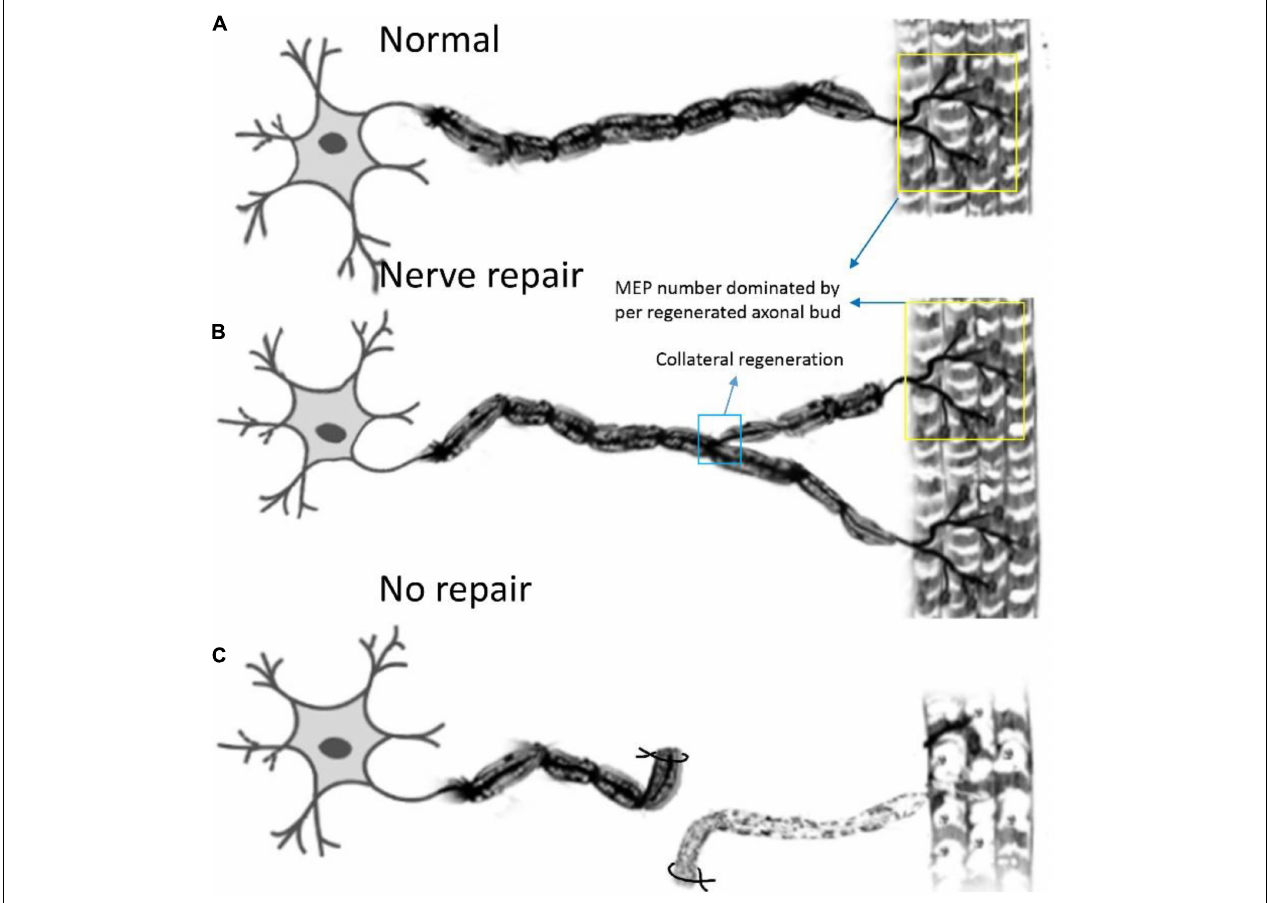
FIGURE 7 | Pattern diagram displaying the reinnervation pattern. (A) The normal control pattern of the motoneuron. (B) One motoneuron sprouts about two axon buds to reinnervate the motor endplates, and the control region of one motoneuron is augmented after collateral regeneration, while the mean number of MEPs, dominated by regenerated axonal buds, remains unchanged. (C) The muscle is denervated due to axonal